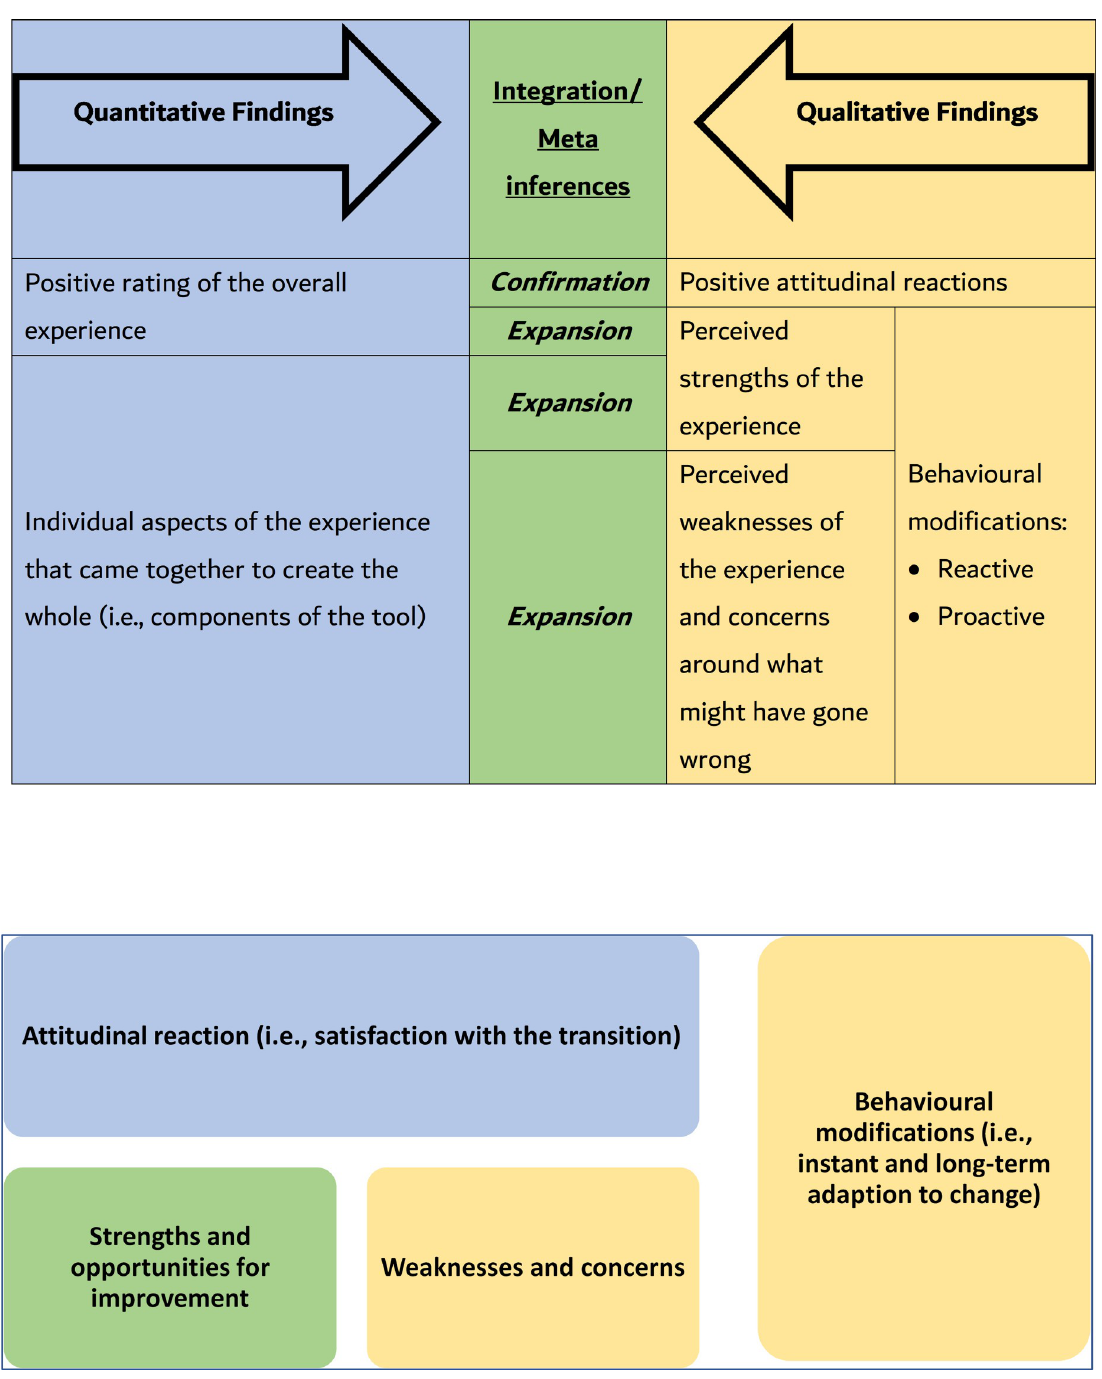
Fig 4. Two iterations of the joint display analysis of the integration across the mixed methods, showing the complementarity of the various outputs of analysis. The first iteration shows how secondary color Green emerged by mixing the primary color Blue with the primary color Yellow (which constitutes an analogy of the lateral and critical thinking that took place, and the meta inferences that were generated). In the second iteration, each quadrilateral represents an area of findings. The Blue area was identified from the quantitative analysis. The Yellow areas were identified from the qualitative analysis. As for the Green areas, they were derived/ interpreted by mapping the findings of the quantitative onto the qualitative ones.